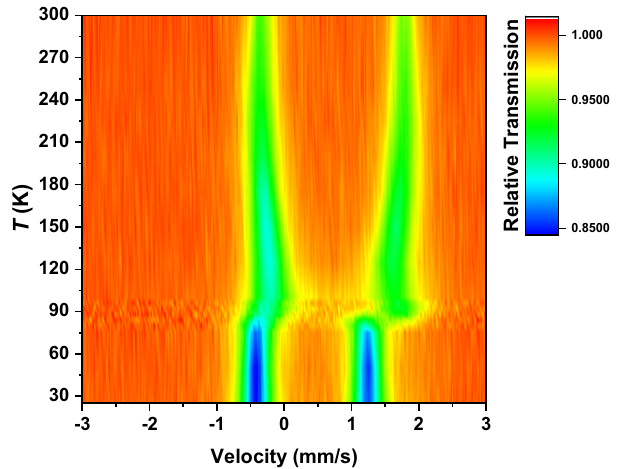
Fig. 7 Variable-temperature Mössbauer spectroscopy of the [FeCo] crystals. Temperature-dependent Mössbauer spectra of 1(PF 6 ) 3 between the temperature range from 300 to 25K. Spin transition is observed at approximately 90K. Upon heating above the spin transition temperature, the quadrupole splitting (QS) value is getting larger, which suggests that the contribution of the C [Fe 2 + HS – dhbq 2 − – Co 3 + LS ] state increases with temperature at the high-temperature